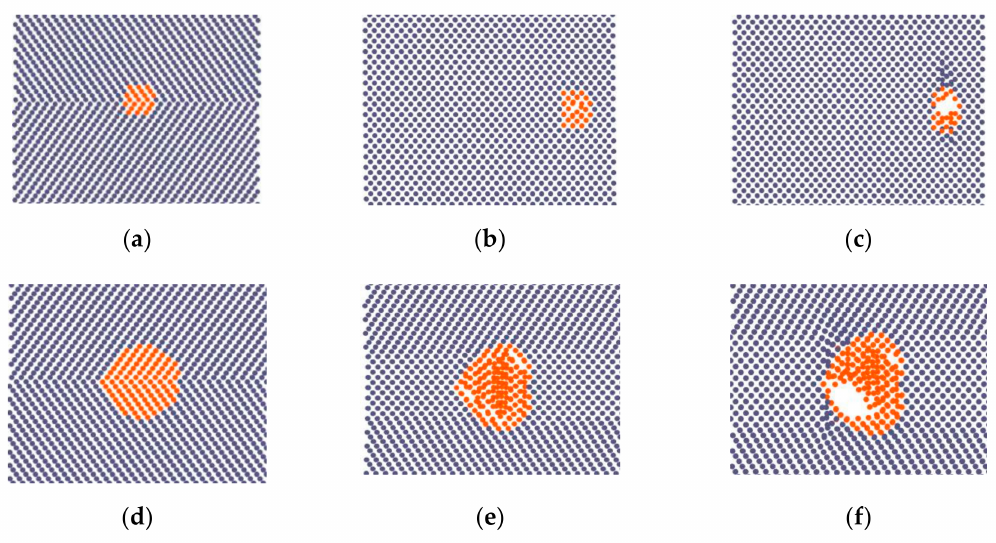
Figure 8. Contains the evolution law of crystal structure at grain boundary with diameters of 10A and 20 Å Cu when the cluster phase is stretched ( a , d ). When the original grain boundary model ( b ) is not stretched, the clusters of 10 Å correspondingly change to 23% ( c ) the clusters of 10 Å correspondingly change to 24% ( e ) the clusters of 20 Å correspondingly change to 9% ( f ) the clusters of 20 Å correspondingly change to